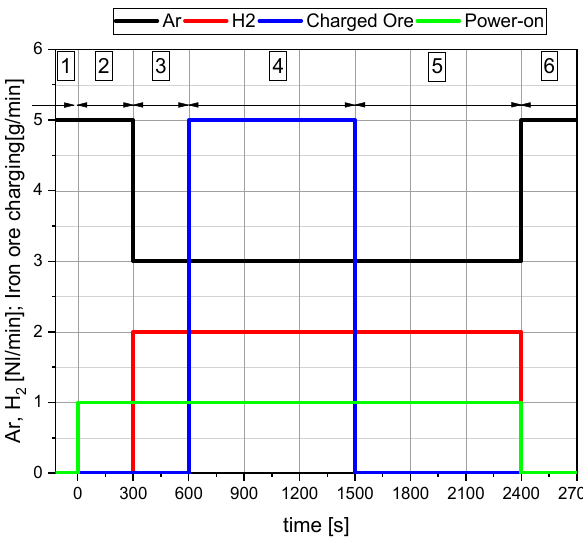
Figure 5. Representation of the performed process steps.